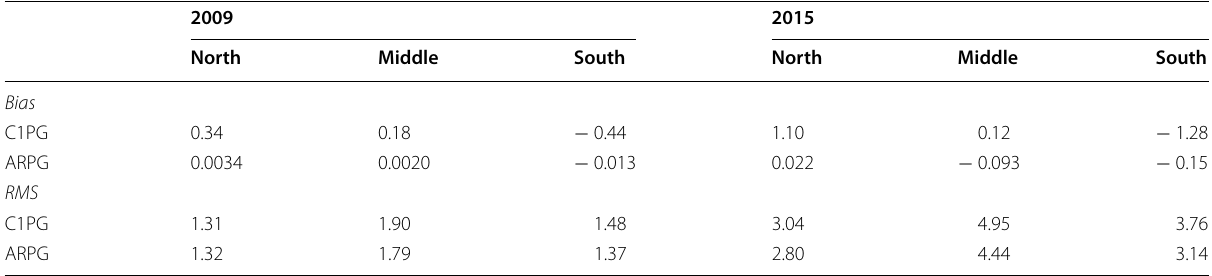
Table 2 Bias and RMS values of the differences between forecasting VTEC values and final CODE VTEC values in